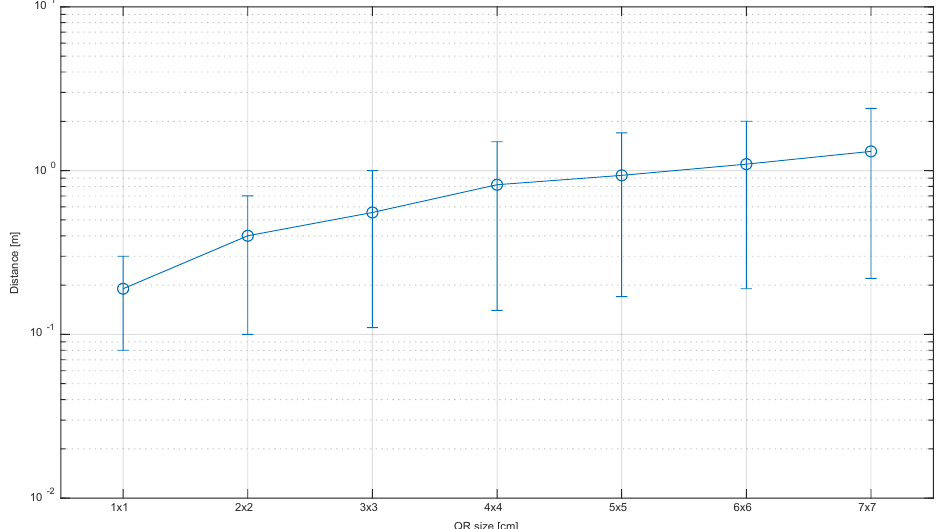
Figure 16. Minimum, maximum, and average successful scanning distances for different QR sizes.